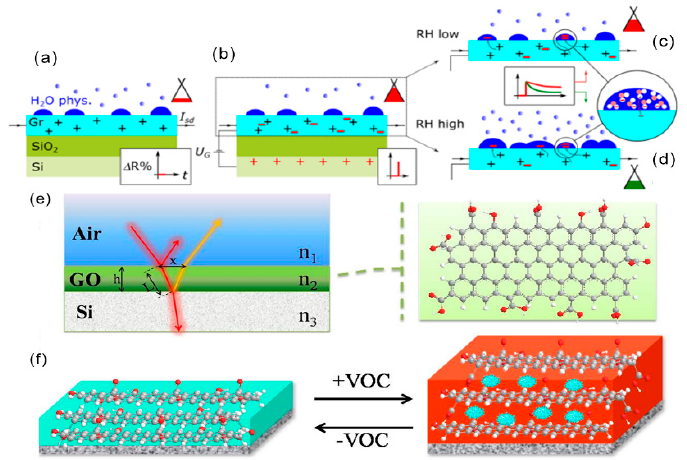
Figure 3. ( a ) Schematic diagram of the initial state of a graphene FET after physical interaction of electrons with water; ( b ) electrons change immediately after the gate voltage is applied; ( c , d ) schematic diagram of the state when a more extended grid voltage is applied ( c ) at lower and ( d ) at higher relative humidity [37]. Copyright (2020), used with permission from Elsevier. ( e ) The principle of thin-film interference structure; ( f ) schematic diagram of VOC gas–sensing mechanism based on gas intercalation and visual response [26]. Copyright (2018), used with permission from